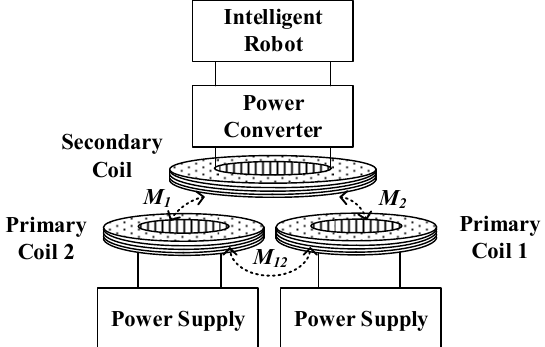
Figure 1. Dual excitation unit wireless power transfer (DEU-WPT) system.